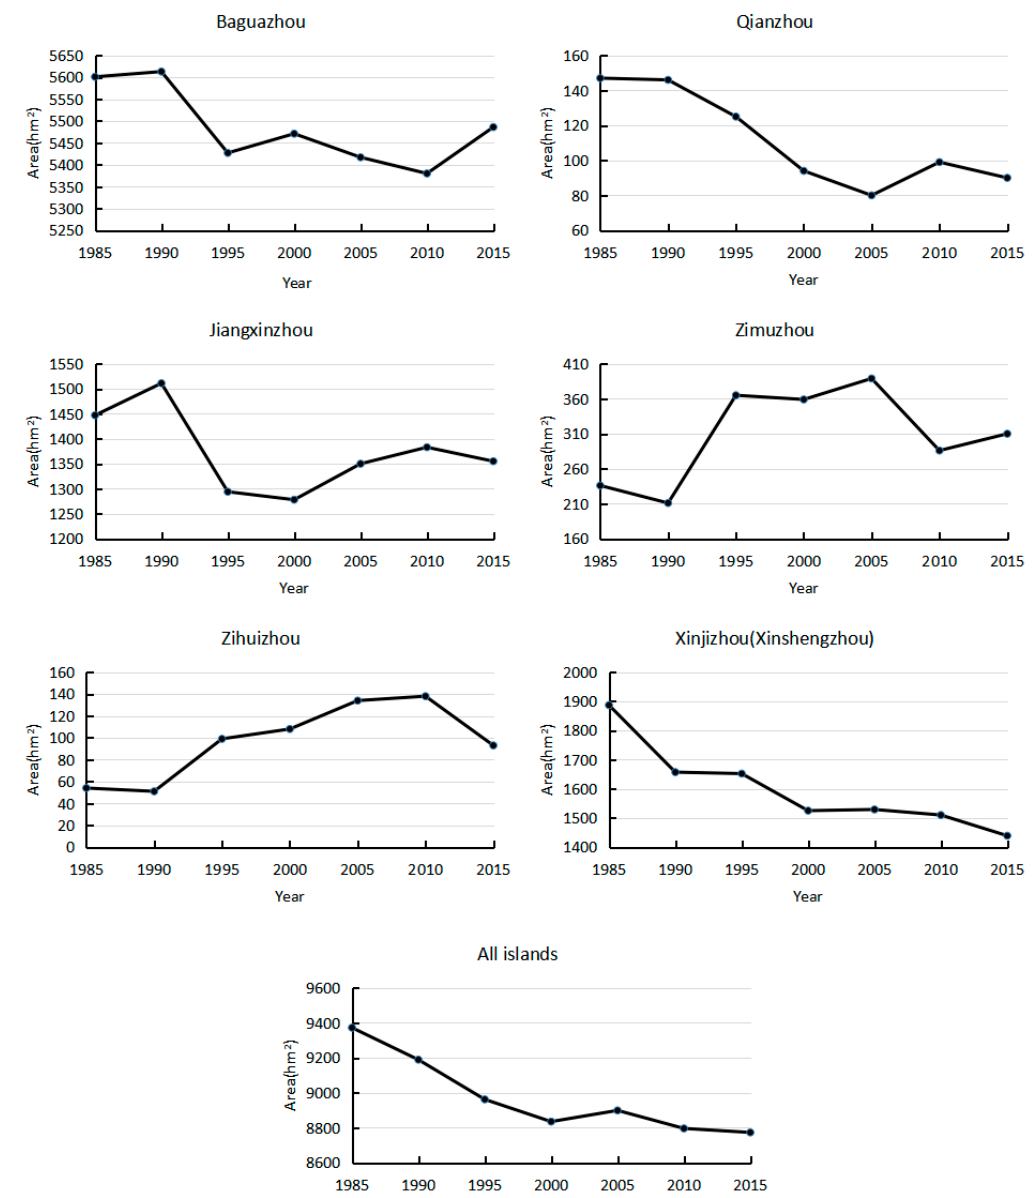
Figure 5. Area changes of river islands in NYR (Nanjing section of the Yangtze River) during 1985–2015 (hm 2 ).